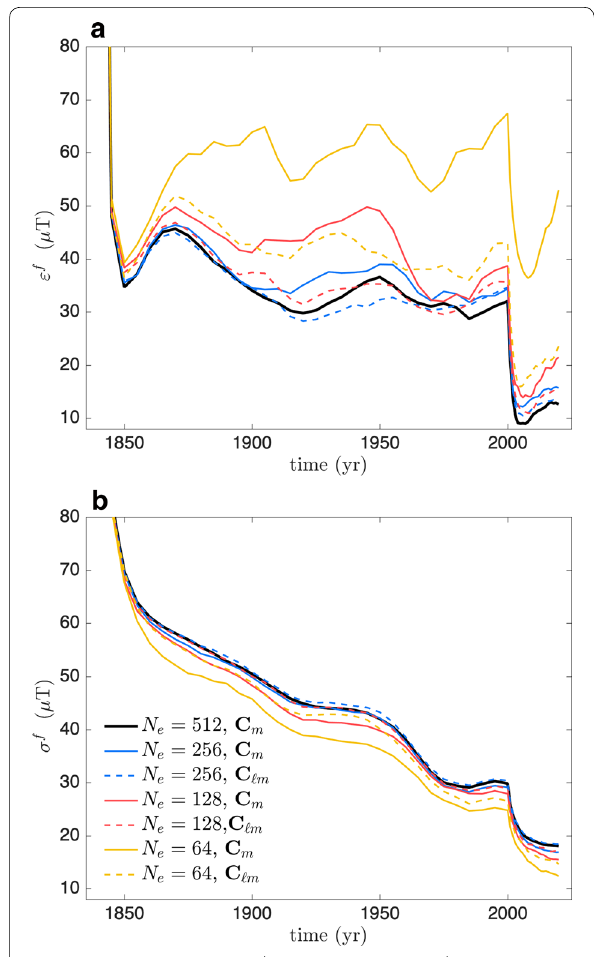
Fig. 3 RMS forecast a errors ε f and b uncertainties σ f of assimilation runs with different ensemble sizes N e and localization C . The RMS values are evaluated at the top of the core and truncated to ℓ =